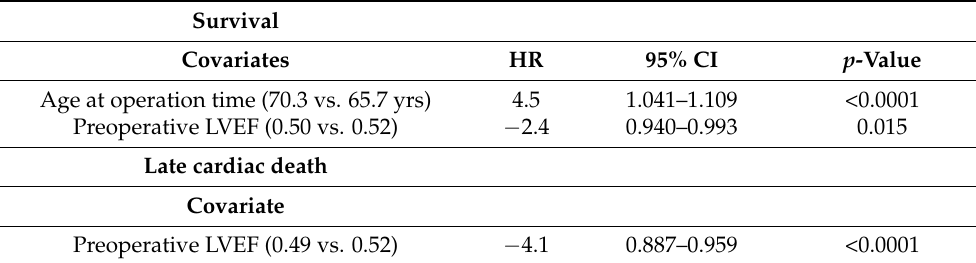
Table 2. Actual rates of adverse events observed during follow-up, not including in-hospital results. C-OPCAB C-CABG p -Value Adverse Events ( n = 141) ( n = 136) Death for any causes, n (%) 40 (28.4) 40 (29.4) NS New MI, n (%) 4 (2.9) 7 (5.0) NS New revascularization, n (%) 4 (2.9) 9 (6.4) NS Stroke, n (%) 1 (0.7) 0 NS Pacemaker/ICD implantation, n (%) 3 (2.1) 10 (7.4) NS